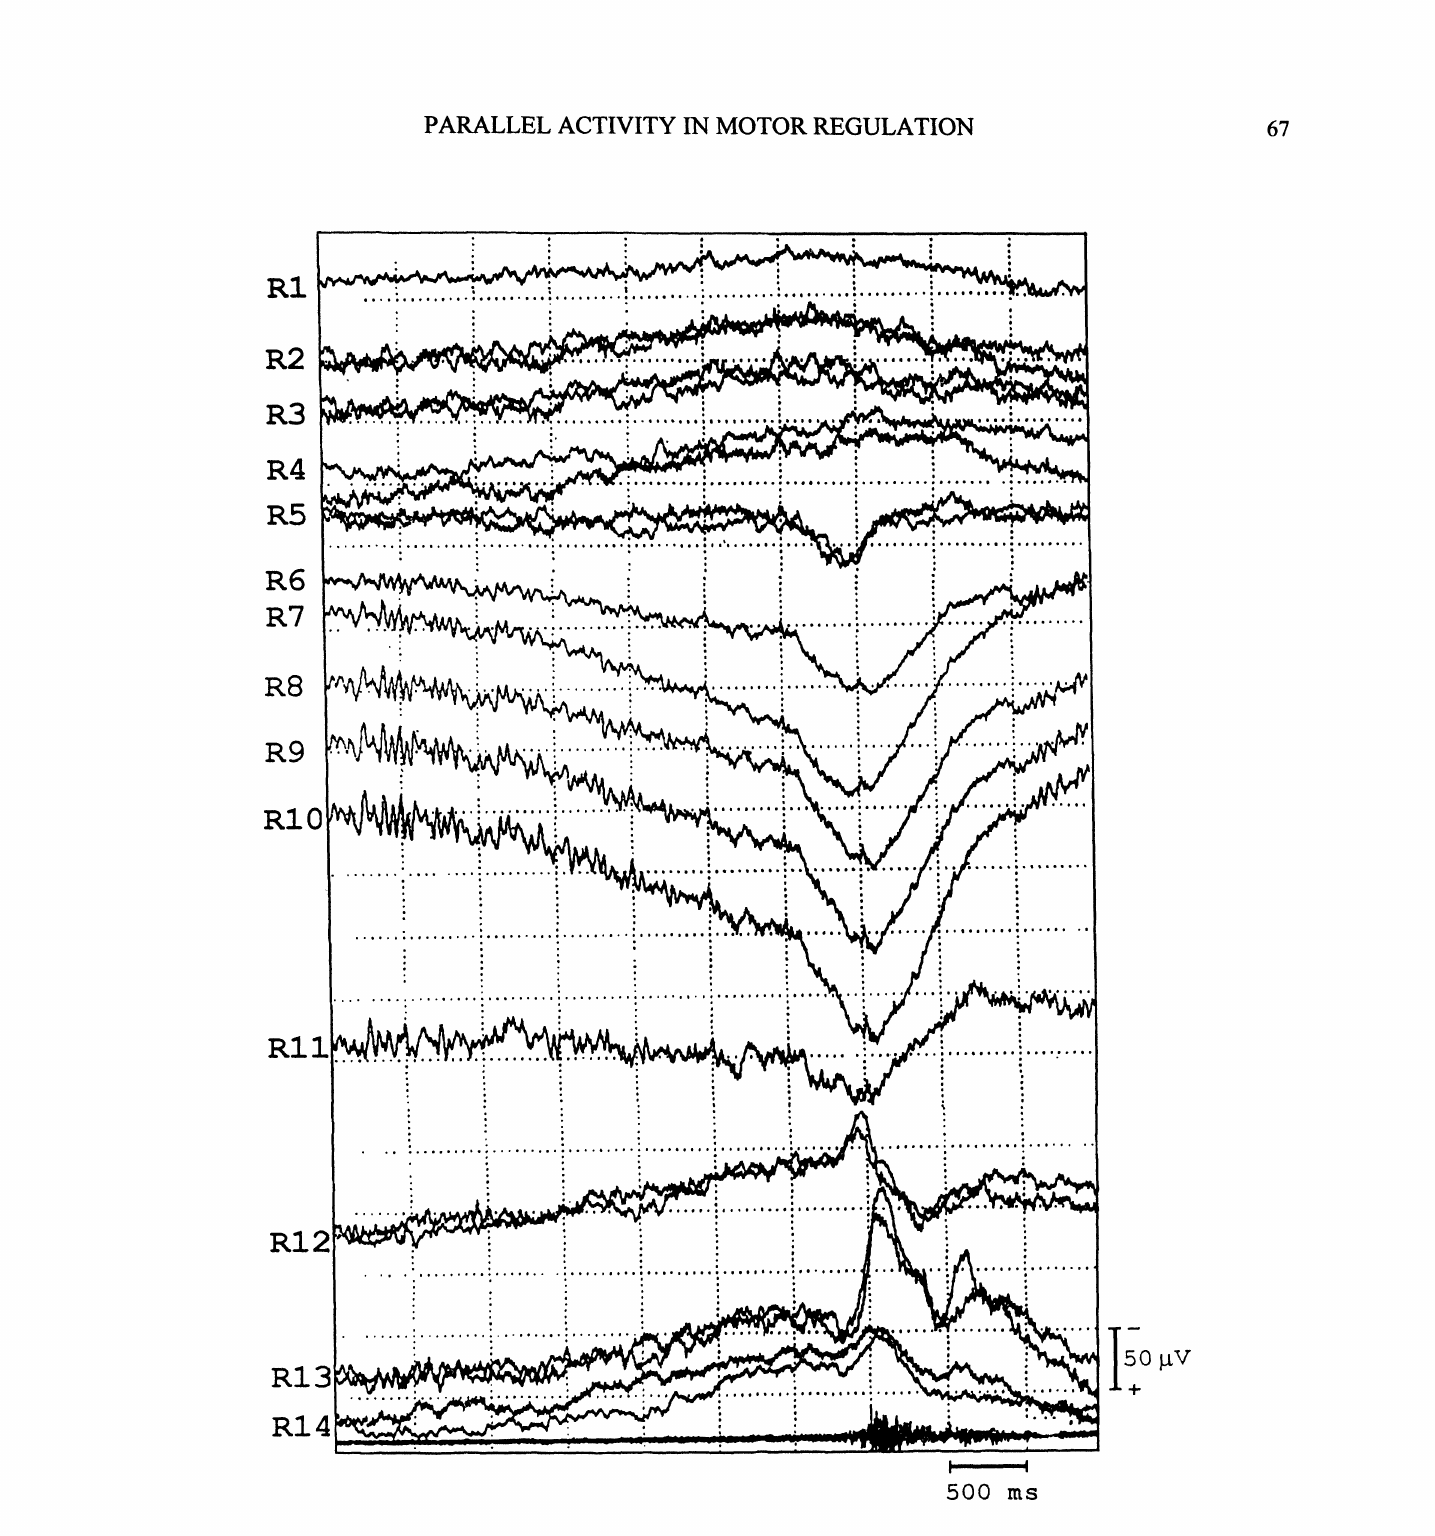
Readiness Potential (RP) and Movement Accompanying Slow Potential (MASP) recorded on consecutive leads on an electrode passing from the post-central cortex (R 14) through the primary motor cortex ( R13- R11; phase reversal between R 11 and R 12) to SMA (R5-R1;phase reversal between R 4 and R 5). EMG: the contralateral (right) hand movement. Results of consecutive tests are superimposed in most cortical contacts (R2-R5 and R12-R14), indicating that MASP is a reproducible phenomenon. Notice variable morphology of MASP, which is displayed both as multiphasic (R12,13) and as monophasic. Even when displayed together, MASP is not a simple component of RP. When recorded on consecutive contacts, the development of RP- and MASP- slopes and their phase reversals differed. Reprinted from: Rektor I. et al. Electroencephalogr clin Neurophysiol, 1998; 107: 277-286, with permission from Elsevier